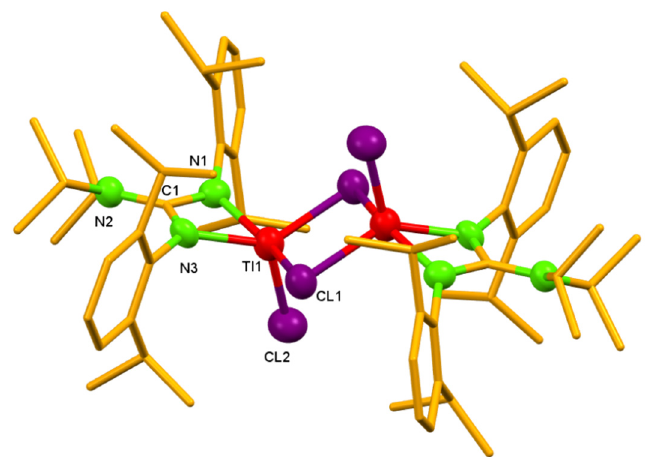
Figure 3. Molecular structure of 2 . Ellipsoids are set at 50% probability; hydrogen atoms and one hexane molecule are omitted for clarity. Selected bond lengths [Å] and angles [°]: C1-N3 1.347(7), C1-N1 1.355(7), C1-N2 1.374(7), N1-Ti1 2.026(5), N3-Ti1 2.078(5), Cl1-Ti1 2.368(2), Cl1A-Ti1 2.403(2),